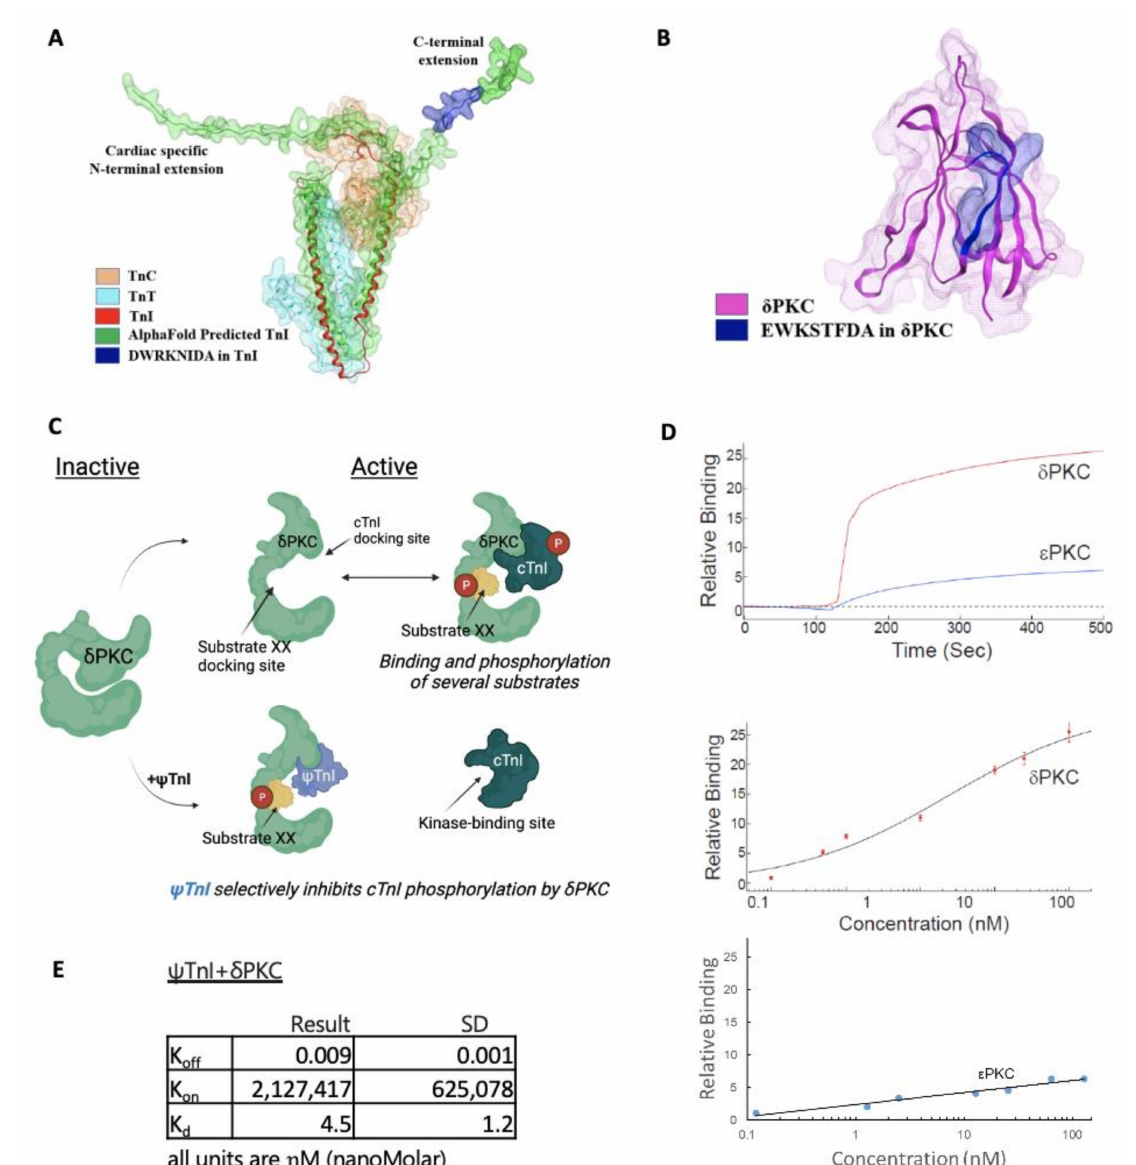
Figure 2. Binding activity and selectivity of ψ TnI in vitro. The ψ TnI sequences (blue surface) are exposed in the C terminus unstructured region of cTnI ( A ), as observed in the AlphaFold predicted structure of cTnI (AF-P19429-F1) [14] shown in the green surface superimposed with troponin I in the crystal structure of the complex of troponin T (cyan surface), C (orange surface), and I (red ribbon) (PDB ID: 4Y99) [15]; they are also exposed in the C2 domain (highlighted in pink; ( B )) in δ PKC. ( C ) A scheme describing the mechanism of an inhibitor that selectively inhibits the docking and phosphorylation of cTnI by the multi-substrate kinase δ PKC. (( C ); top) Intramolecular interactions in δ PKC are disrupted by PKC activation, exposing the catalytic site and selective substrate docking sites on δ PKC. Docking of these substrates to the kinase, concomitantly or one substrate at a time, increases the access of the catalytic site for the substrates, leading to their phosphorylation (red P circles). In the inactive δ PKC (left), the docking site interacts with a PKC sequence, e.g., ψ TnI site, which mimics the kinase docking site on cTnI. (( C ); bottom). ψ TnI is a competitive inhibitor of docking and phosphorylation of cTnI by δ PKC; it does not affect docking and phosphorylation of other δ PKC substrates (e.g., substrate XX, yellow). ( D ) Binding curves of δ PKC and ε PKC, at 75 µ g/mL (about 1 µ M), to ψ TnI (6 µ M). The peptide selectivity binds to δ PKC, and not to another novel PKC, ε PKC. Binding assay with increasing amounts of δ PKC to ψ TnI and binding assay with increasing amounts of ε PKC. ( E ) Calculated K off , K on , and K d between ψ TnI and δ PKC, shown in η M. Results are from three independent